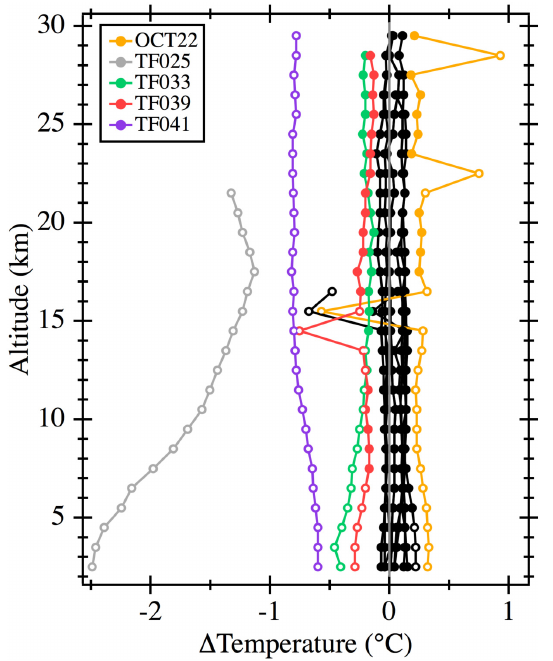
Fig. 3. Profiles of 1T for paired RS92 sondes. Five anomalous dif- ference profiles are identified by their flight numbers. Open circles denote the 28% of 1T that exceed manufacturerquoted limits (1 σ ) for T measurement reproducibility (Table 2). All but 5 of these excessive 1T belong to the five anomalous profiles.